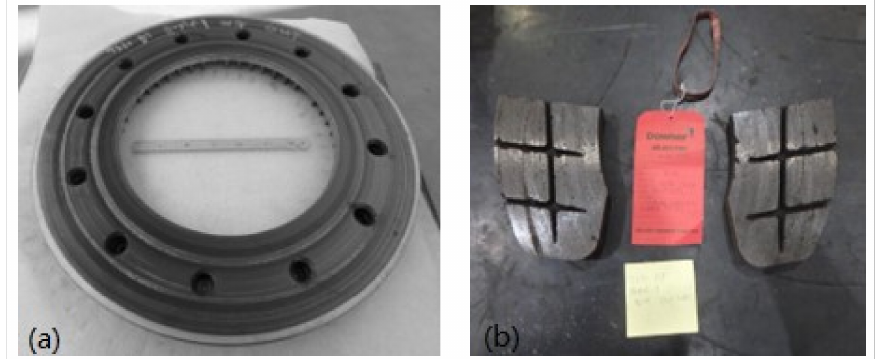
Figure 2. ( a ) General view of Brake Disc 2 from an unaffected trainset. ( b ) General view of Brake Pad 2 from an unaffected